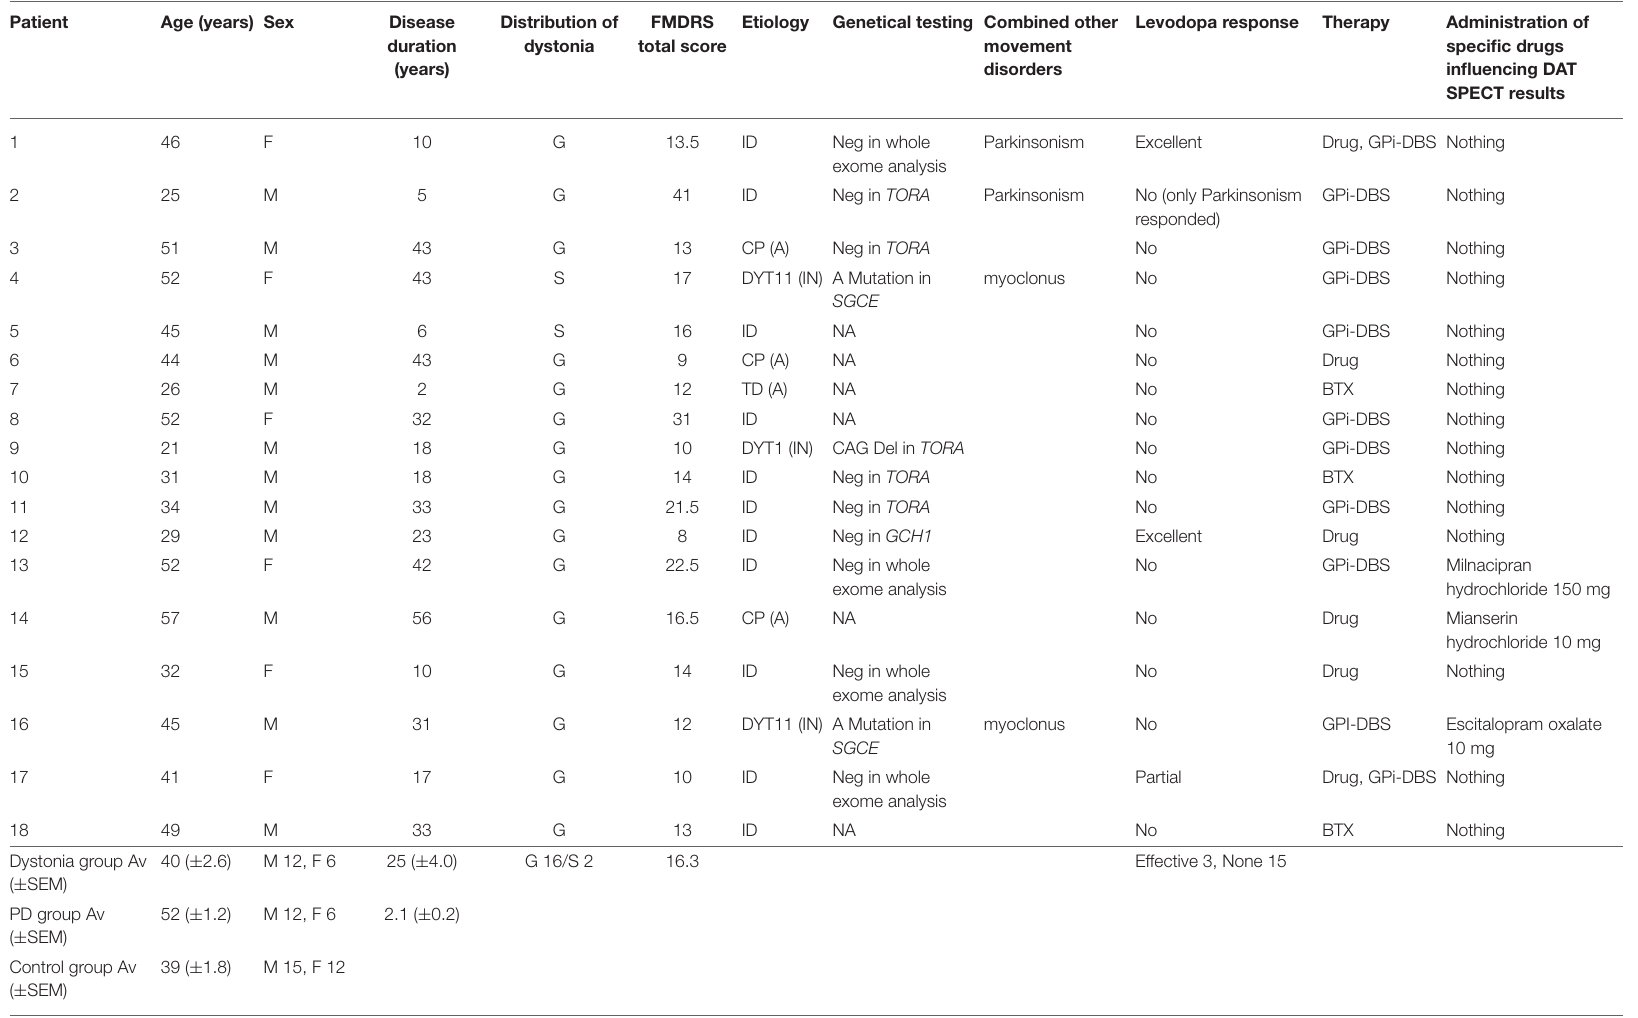
TABLE 1 | Clinical details of